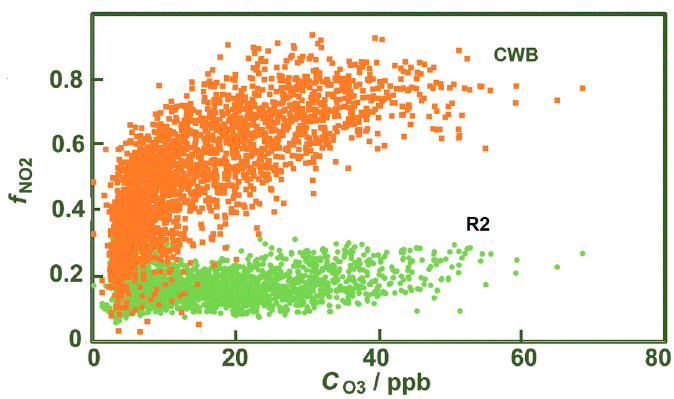
Figure 7. The fraction of NO 2 ( f NO2 ) at node R2 and the Causeway Bay monitoring station (CWB) at 1-min intervals across the four days as a function of the concentration of ozone ( C O3 ) measured at the monitoring station.